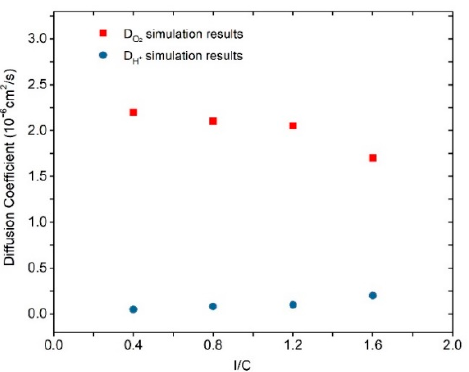
Figure 9. Diffusion coefficient of oxygen and hydronium ions at different ionomer-to-carbon ratios.